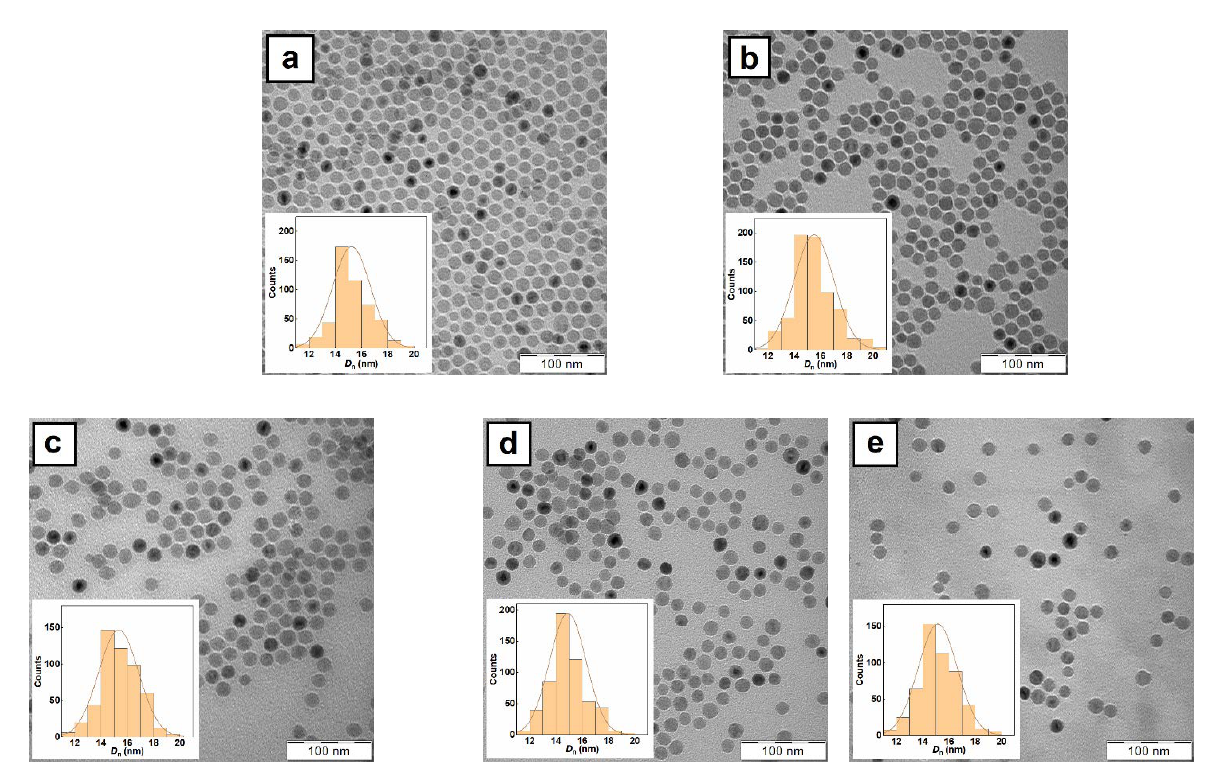
Figure 2. TEM micrographs of ( a ) MNP, ( b ) MNP@S, ( c ) MNP@S-D, ( d ) MNP@S-D-T1, and ( e ) MNP@S-D-T2.